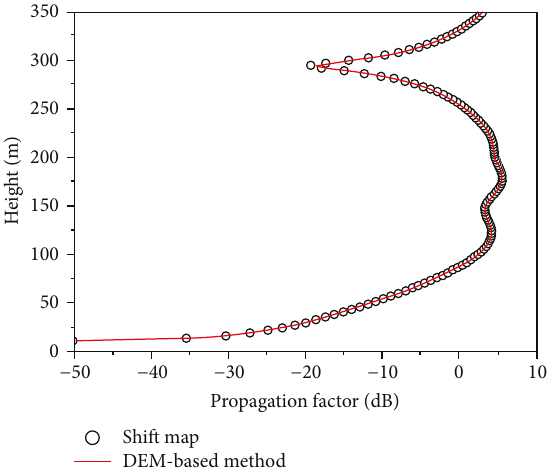
Figure 6: Propagation factor versus height at range 50km.